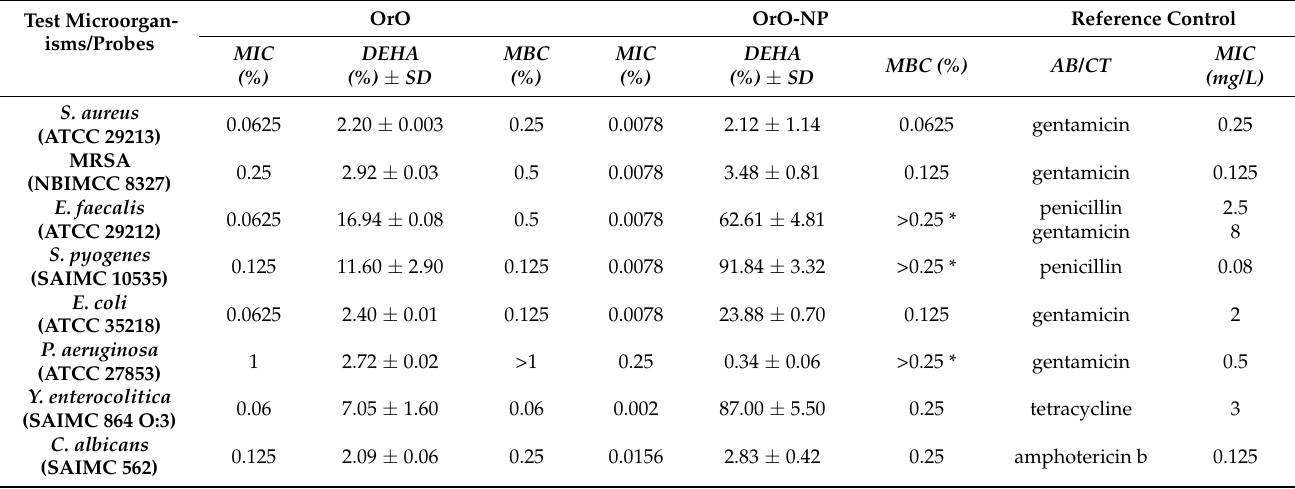
Figure 3. DTG curves of oregano oil ( a ), chitosan–alginate ( b ), and oregano oil–loaded chitosan– alginate ( c ). Table 2. Antimicrobial activity of oregano oil: comparison between pure oil and a nanoformulation based on chitosan and sodium